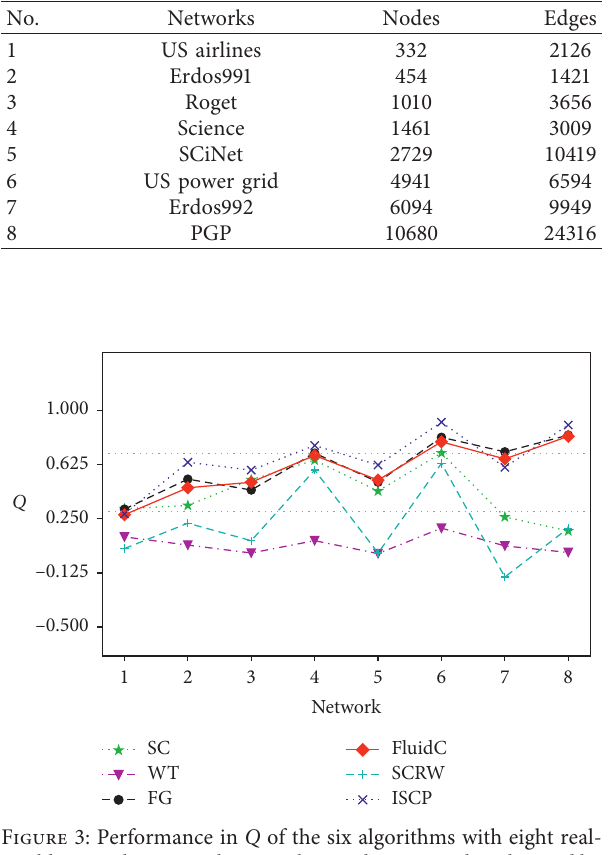
Figure 3: Performance in Q of the six algorithms with eight real- world networks. For each network, Q is the mean value obtained by clustering the same network for different community numbers K . K is from 20 to 100, the step length of K is 10, and the number of iterations is 9. (The two yellow reference lines are 0.3 and 0.7 respectively.)